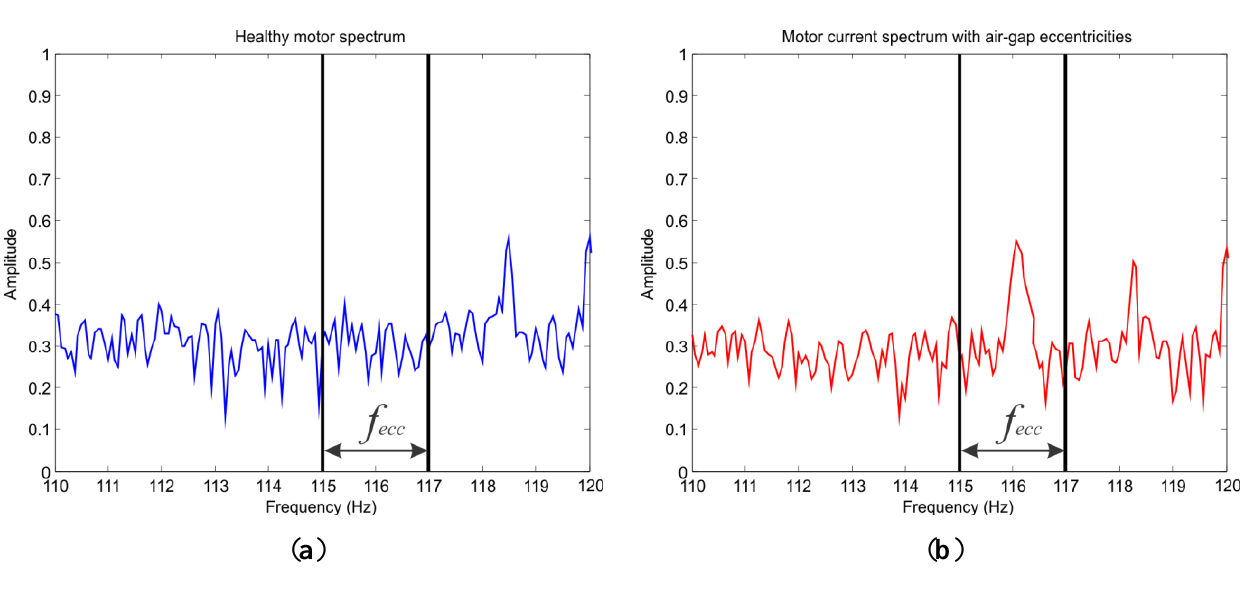
Figure 3. Multilayer feed-forward network